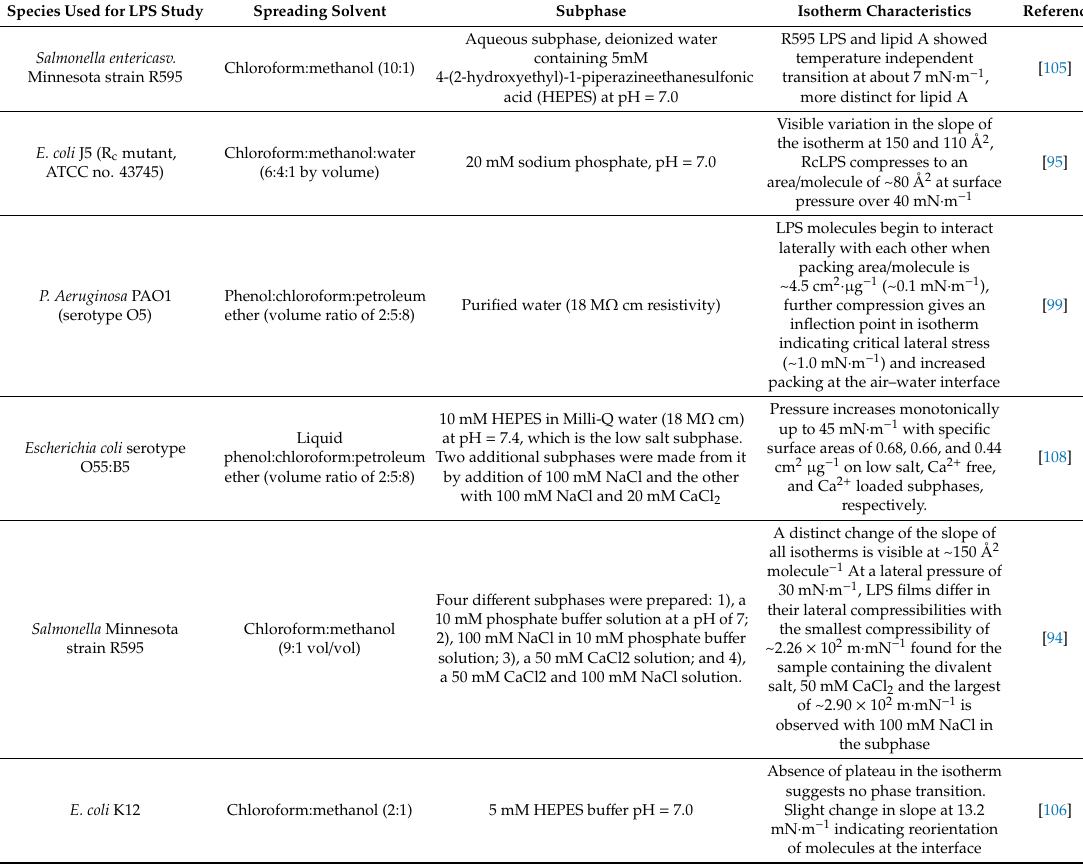
Table 2. Conditions used for the preparation of LPS monolayers at the air–water interface and key isotherm